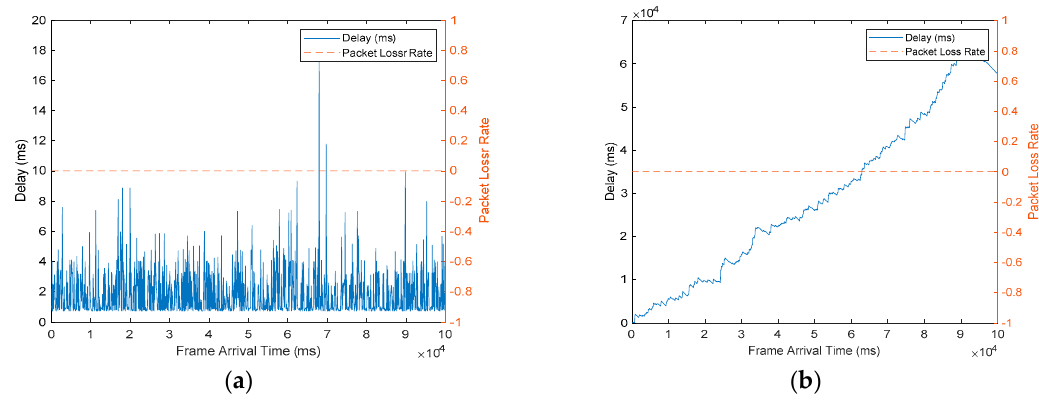
Figure 10. Delay and packet loss rate (PLR) of a single V2X STA for conventional IEEE 802.11p channel access in a single band transmission: ( a ) 60 V2X STAs scenario; ( b ) 80 V2X STAs scenario.